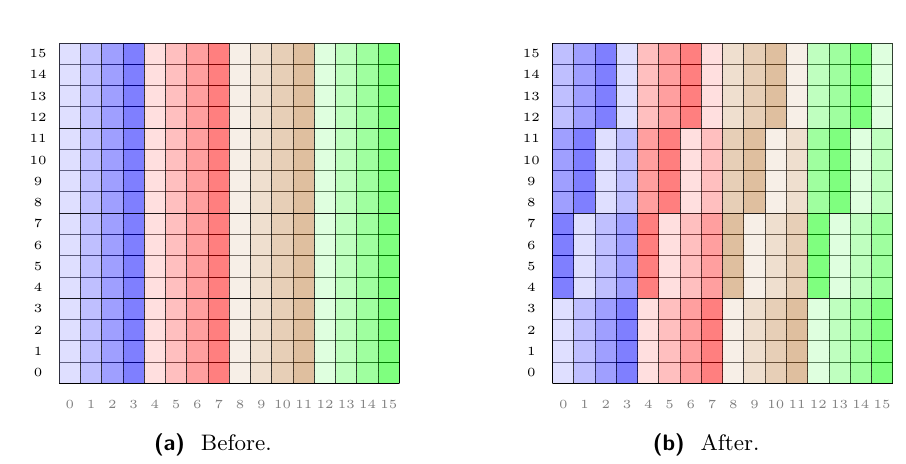
Figure 13: The SR slice operation that mixes the columns in each slice separately.